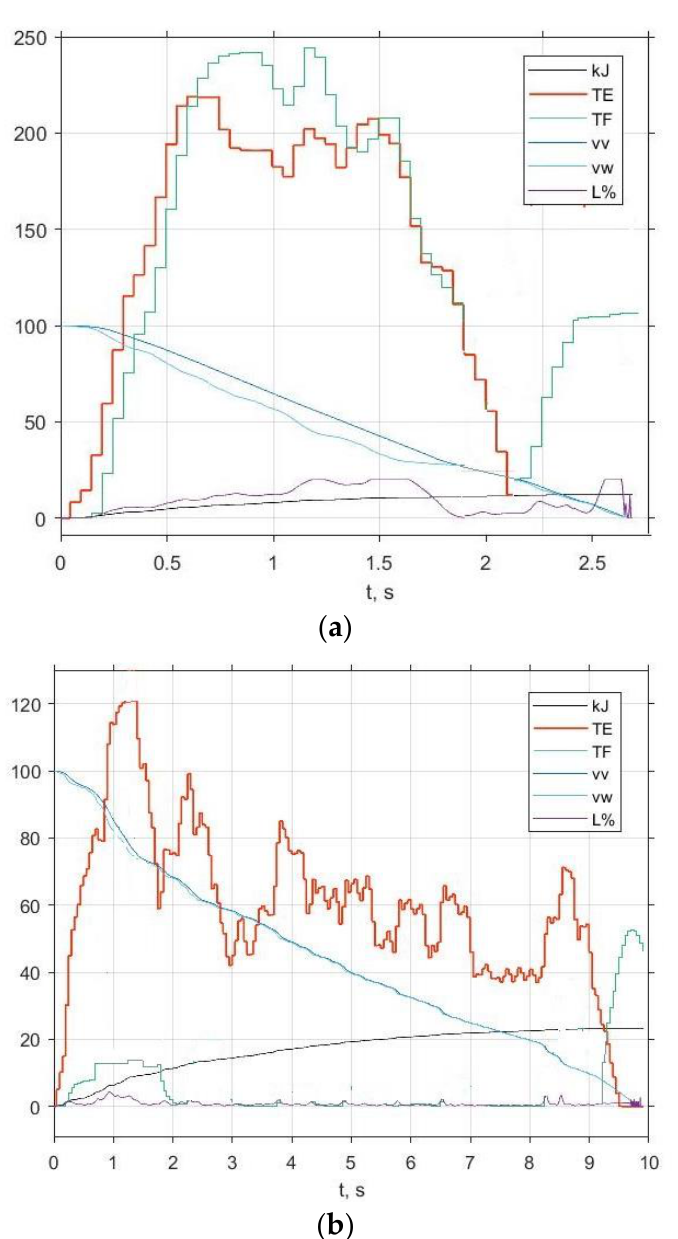
Figure 10. Simulation results: ( a ) on dry asphalt and ( b ) on icy surface.